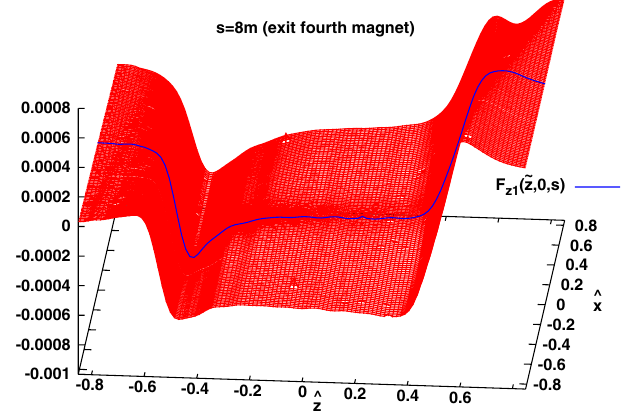
FIG. 19. The same as in Fig. 18 for s ¼ 8 m (end of chicane). The validity of the 1D field approximation scheme is clearly showing a weak dependence on ~ x . shown here, with F z 1